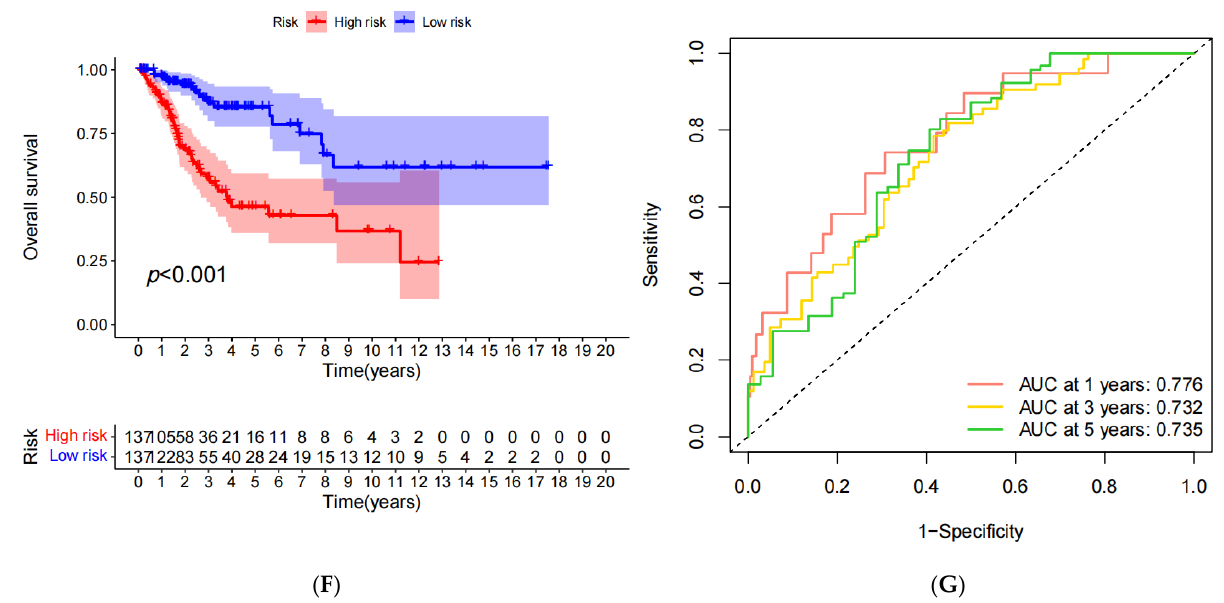
Figure 3. The identified anoikis-related prognosis signature. ( A ) The univariate Cox regression analysis of the differentially expressed ANRGs. ( B ) The least absolute shrinkage and selection operator (LASSO) analysis of the 12 prognostic ANRGs. ( C ) The coefficient profile plot of the 12 prognostic ANRGs. ( D , E ) The relationships between the risk scores (top), the risk scores and the survival status (middle), the risk scores and the gene expression in the TCGA-CESC training set, and the risk scores and the GSE44001 validation set. ( F ) The Kaplan–Meier (K-M) curve shows the prognosis for the different risk groups. ( G ) The time-dependent receiver operational feature curve (ROC) curve for the OS at years 1, 3, and 5. AUC: the areas under the